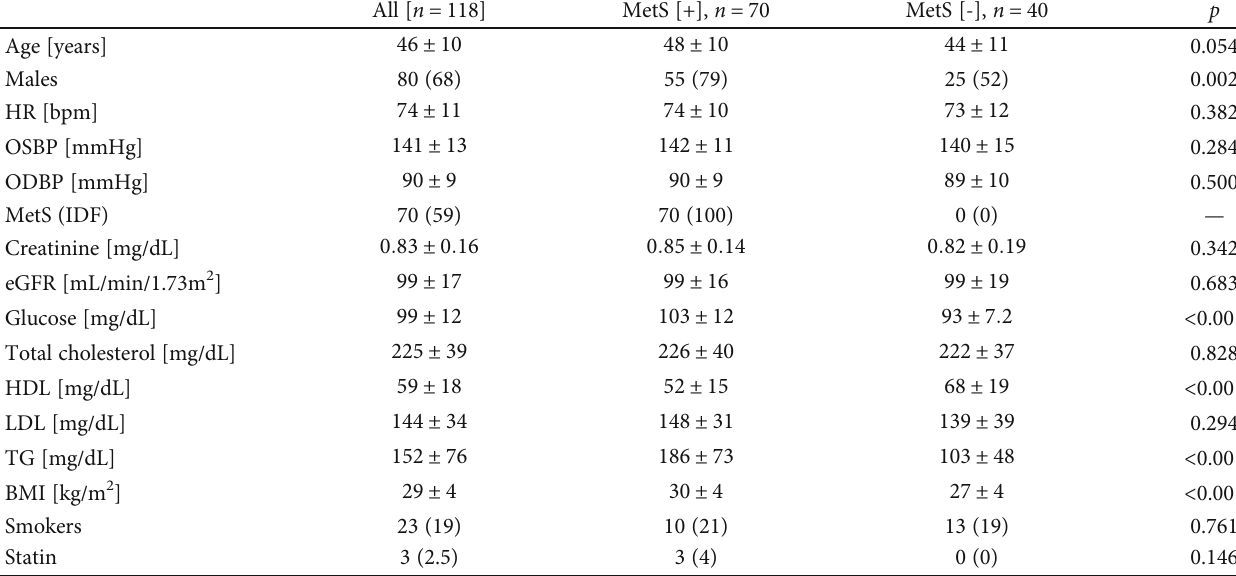
Table 1: Baseline patient characteristics (the entire study population).